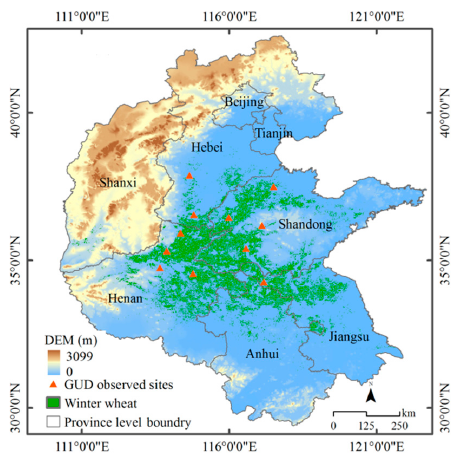
Figure 1. The spatial distribution of winter wheat cropland and eleven agro-meteorological stations in the North China Plain, China.